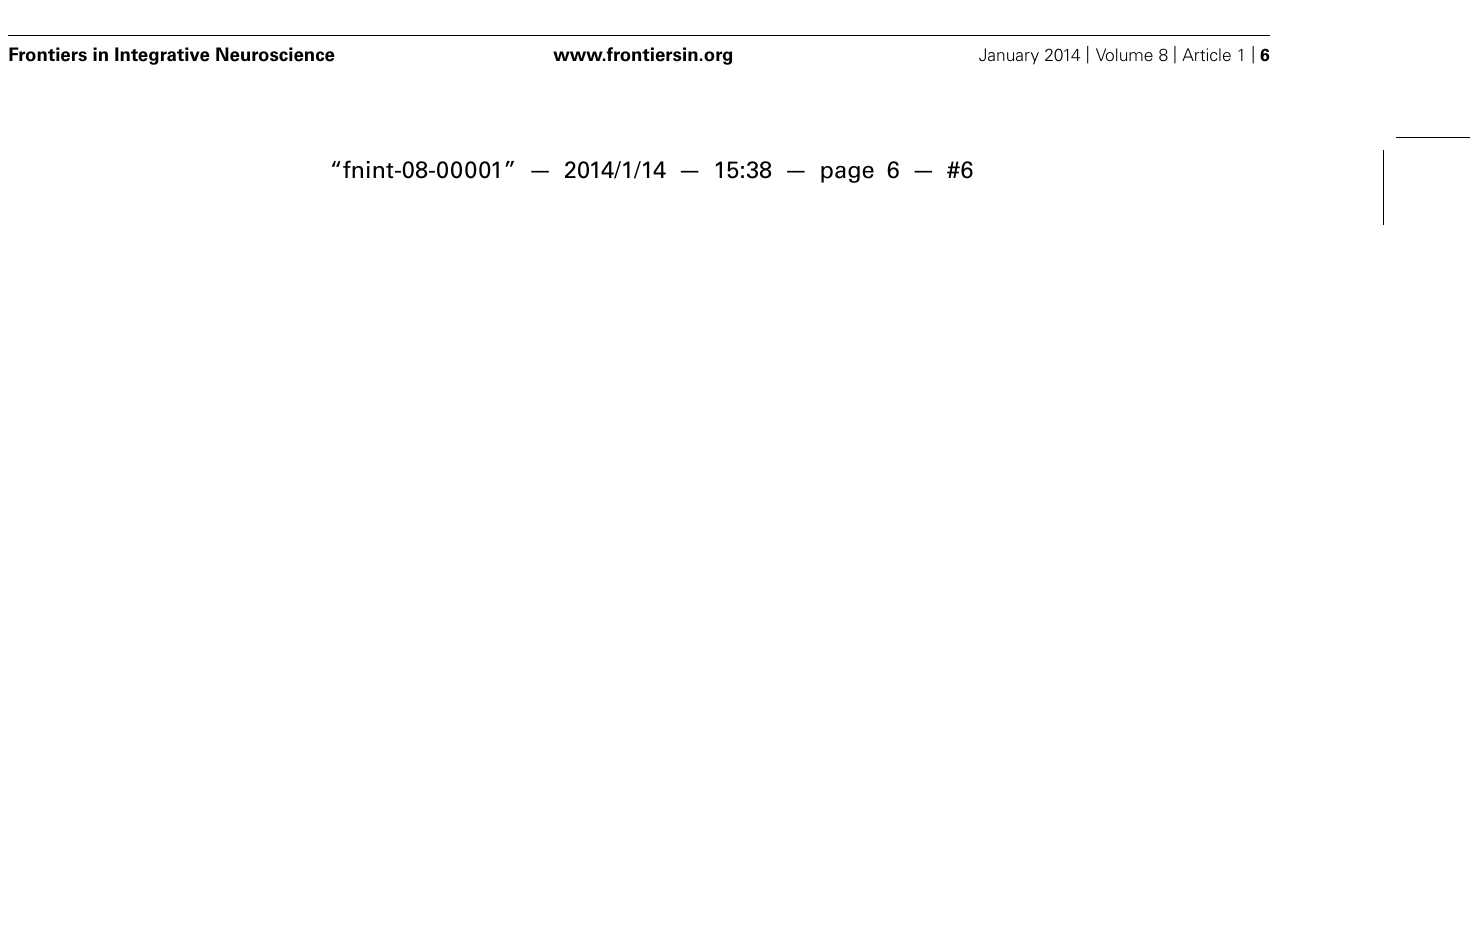
FIGURE 4 | Stimulus protocols used to differentiate stimulus-specific adaptation (SSA) from non-specific adaptation. (A) The priming protocol. In the priming protocol a tuning curve is generated by presenting sequences of stimuli varying randomly over a range of stimuli (f1–fn).This is repeated in two conditions: in one, the stimuli for generating the tuning curve are spaced with a fixed time interval of no stimulation (the control); in the other, in between stimuli, a standard stimulus (fs) is presented several times. In non-specific adaptation (left graph), the tuning curve in the primed condition (gray curve) is expected to be attenuated evenly relative to the control. In SSA, the adaptation is expected to occur stronger near the fs stimulus, resulting in a dip in the tuning curve. (B) The oddball protocol. In the oddball protocol, two different stimuli are chosen (f1 and f2) so that both are within the response range of the neuron, giving rise to about the same response. One stimulus is chosen as the standard, being presented repeatedly for a long period.Within this sequence, the second stimulus, called the deviant, is